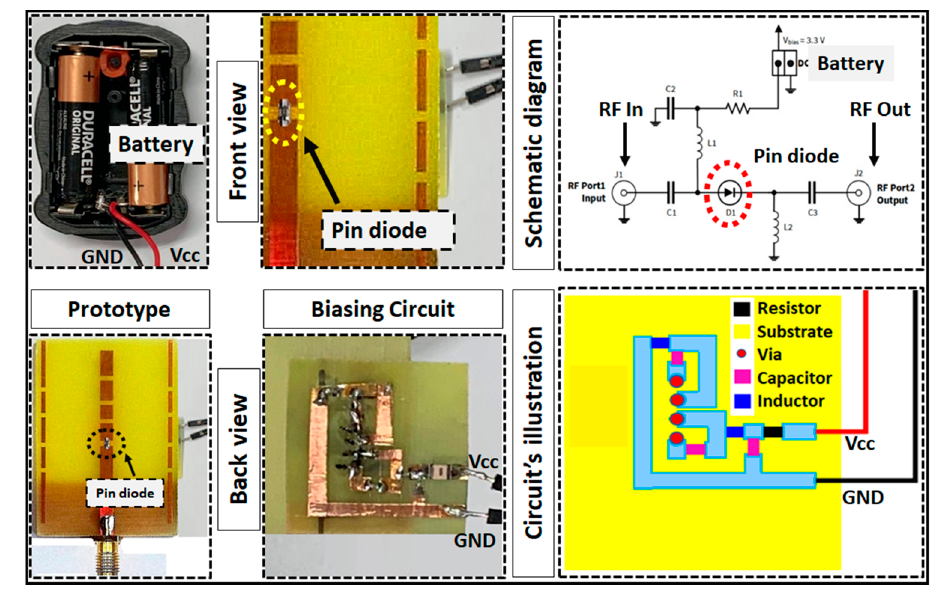
Figure 3. Biasing configuration of Mode 2 with fabricated prototype. Table 2. Different mode of switching for frequency